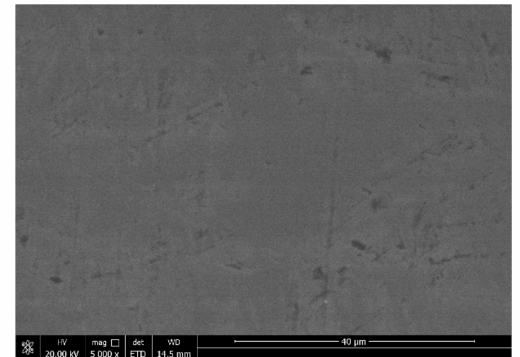
Figure 3. Surface morphology of the 45